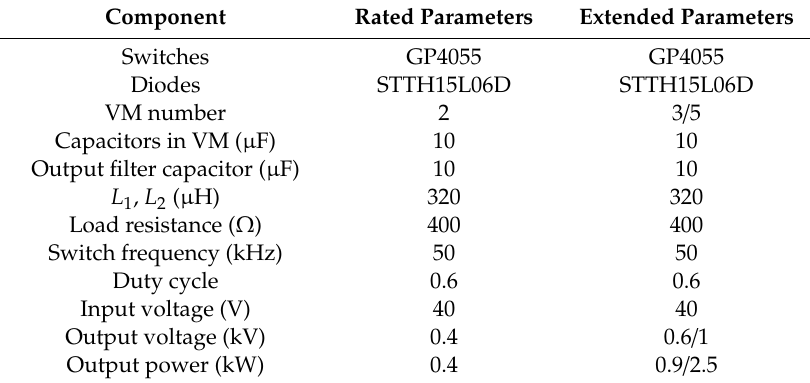
Table 3. Parameters of Simulation and Experimental Prototype.